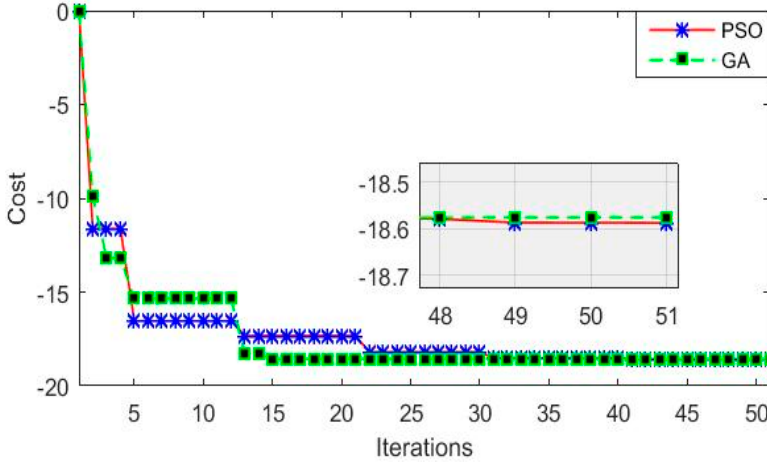
Figure 14. Cost minimization of F 1.